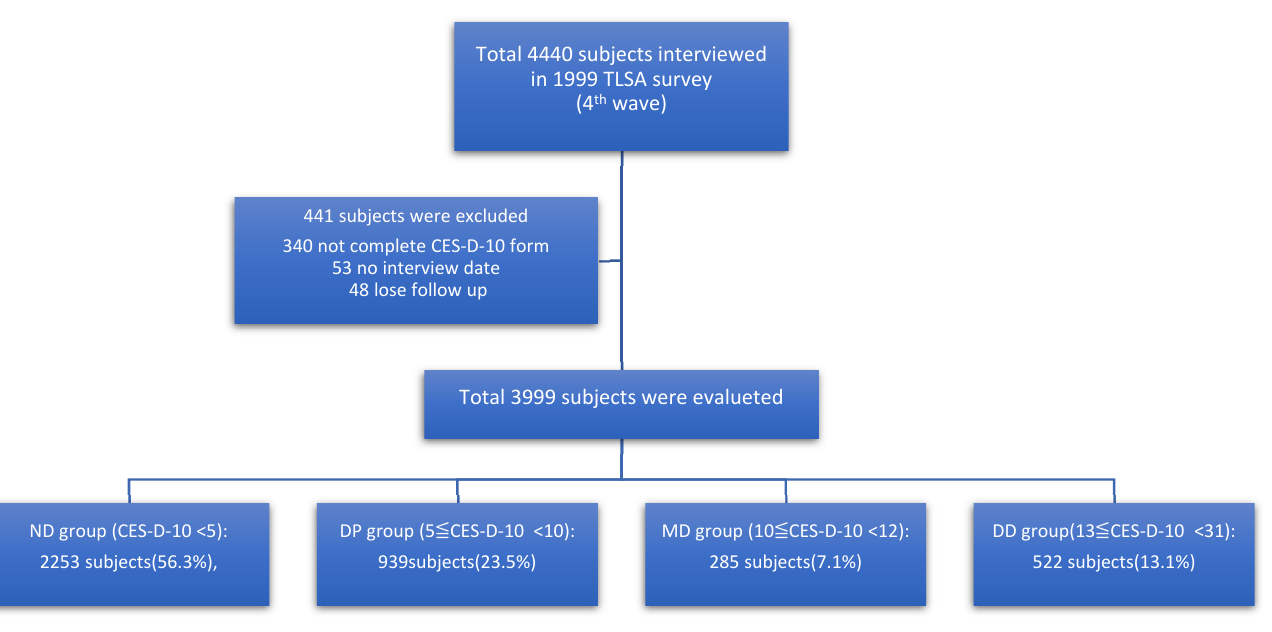
Figure 1. A flow diagram of the subject-inclusion process.